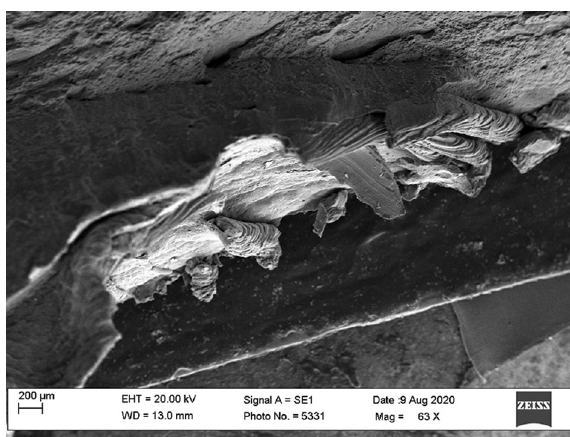
Figure 13. SEM image of non-coated welded joints.